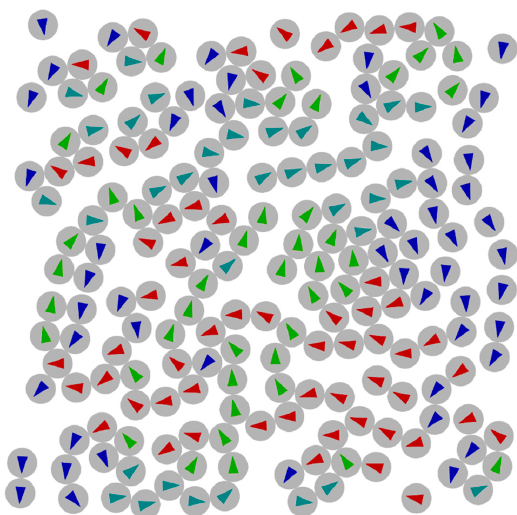
Figure 4. Micromagnetic simulation of nanoparticles (20 nm) combined with a molecular dynamics simulation to model clustering of particles, see [27].